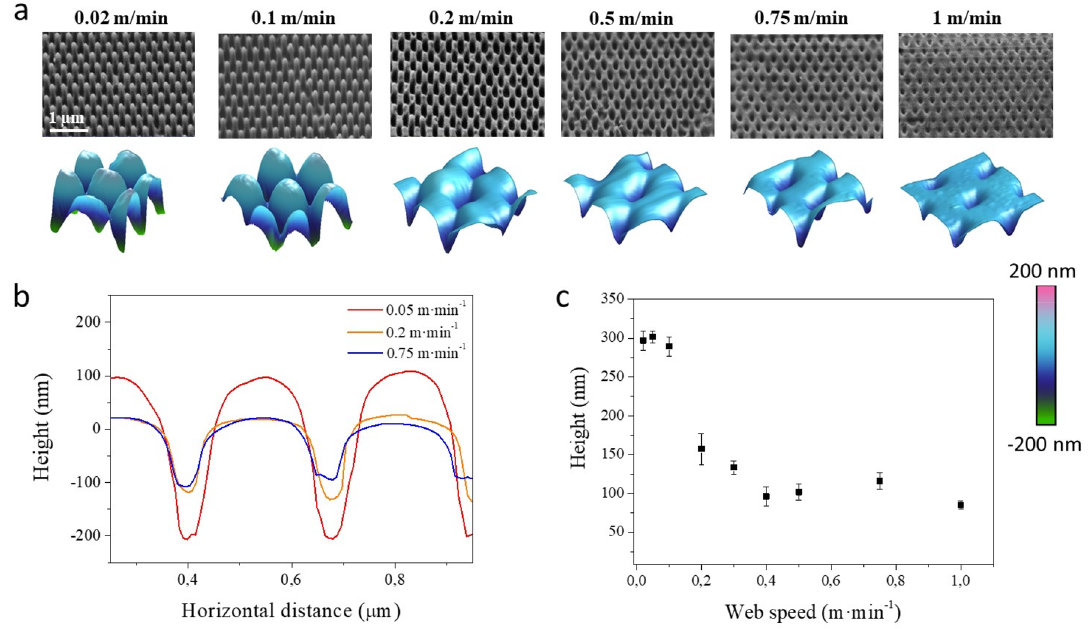
Figure 7. ( a ) SEM images of PMMA R2R nanoimprinted moth-eye structures fabricated at constant roll temperature (T = 110 °C) and at different web speeds as noted. SEM images were acquired at a tilting angle of 45° with an equivalent rotation angle in all cases. Bottom row shows the 3D reconstruction of AFM scans of 550 × 550 nm 2 areas. ( b ) AFM height profiles corresponding to selected processing temperatures. ( c ) Height dependence of the nanoscopic features with processing speed.